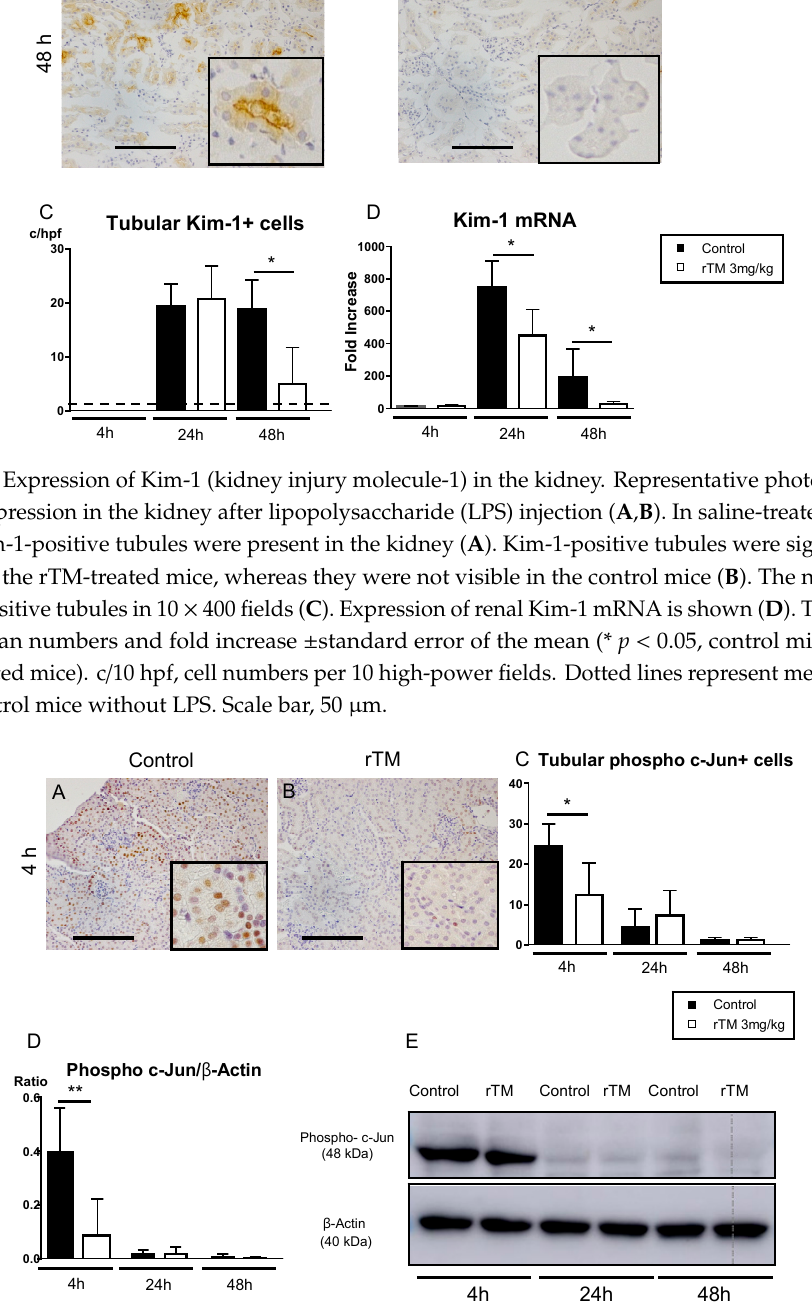
Figure 6. Expression of phospho c-Jun in kidney and spleen cells. Representative photograph of phospho c-Jun expression in the kidney after lipopolysaccharide (LPS) injection ( A , B ). In saline-treated control mice, phospho c-Jun-positive tubules were present in the kidney ( A ). Fewer c-Jun-positive cells were seen in rTM-treated mice than in the control mice ( B ). The number of c-Jun-positive tubules in 10 × 400 fields ( C ). Activation of splenic phospho c-Jun were assayed as protein levels by Western blotting ( D , E ). The data are the mean ± standard error of the mean (* p < 0.05 and ** p < 0.01, cell numbers and band density in control versus rTM-treated mice). Scale bar, 5 μ m.